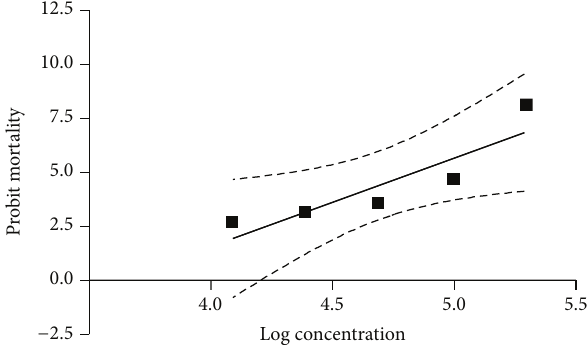
(1.25%, 2.5%, 5%, 10%, and 20%) of A. belladonna and scopo- lamine (0.1%) and atropine (0.1%) according to FAO [18]. The filter papers (7.5 × 9.0 cm, Whatman No. 1, Maidstone, UK)